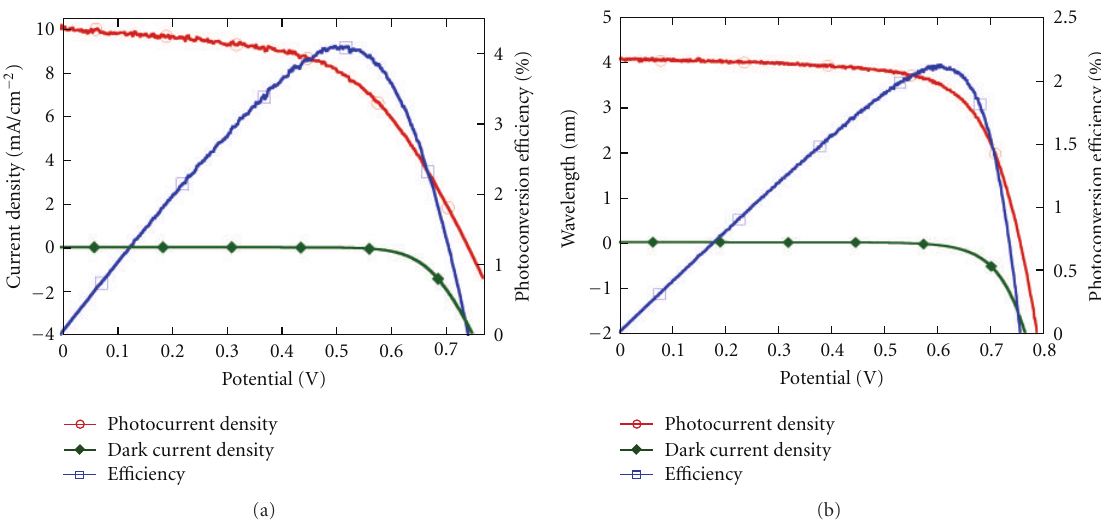
Figure 22: (a) Current-voltage characteristics of frontside illuminated solar cells with Ru-TPANCS-sensitized 1 μ m long TiCl 4 -treated TiO 2 nanotube array under 1 sun AM 1.5 illumination. (b) AM 1.5 current-voltage characteristics of a TiCl 4 -treated 1 μ m long transparent nanotube array with N-719. Reprinted with permission from